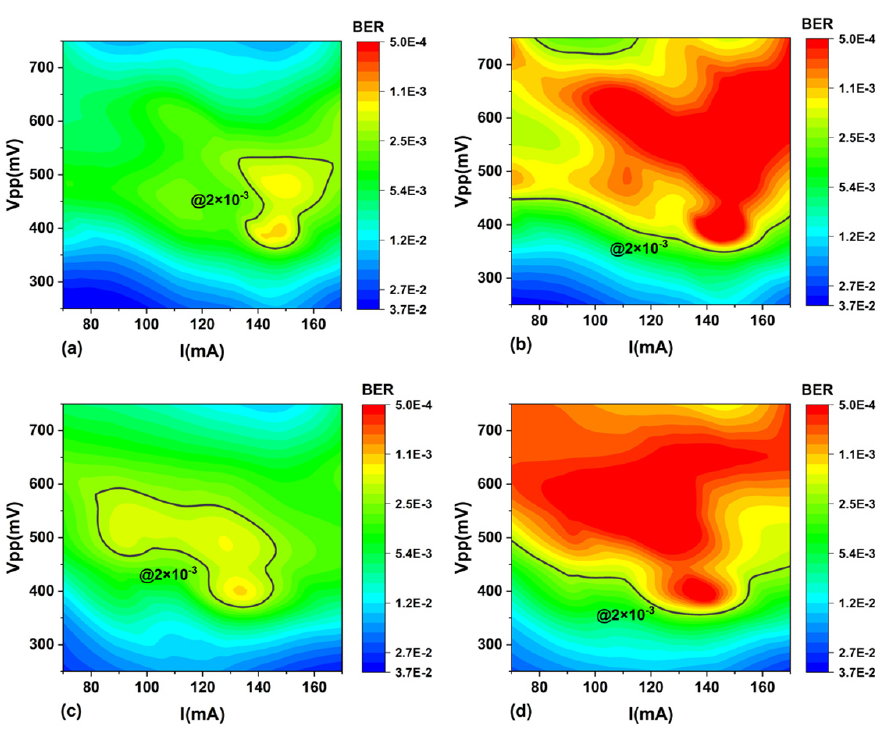
Figure 6. The contour of BER versus different bias currents and signal Vpp for ( a ) 64 APSK, tradi- tional CAP demodulation; ( b ) 64APSK, DNN converter; ( c ) 64QAM, traditional CAP demodulation; ( d ) 64QAM, DNN converter.